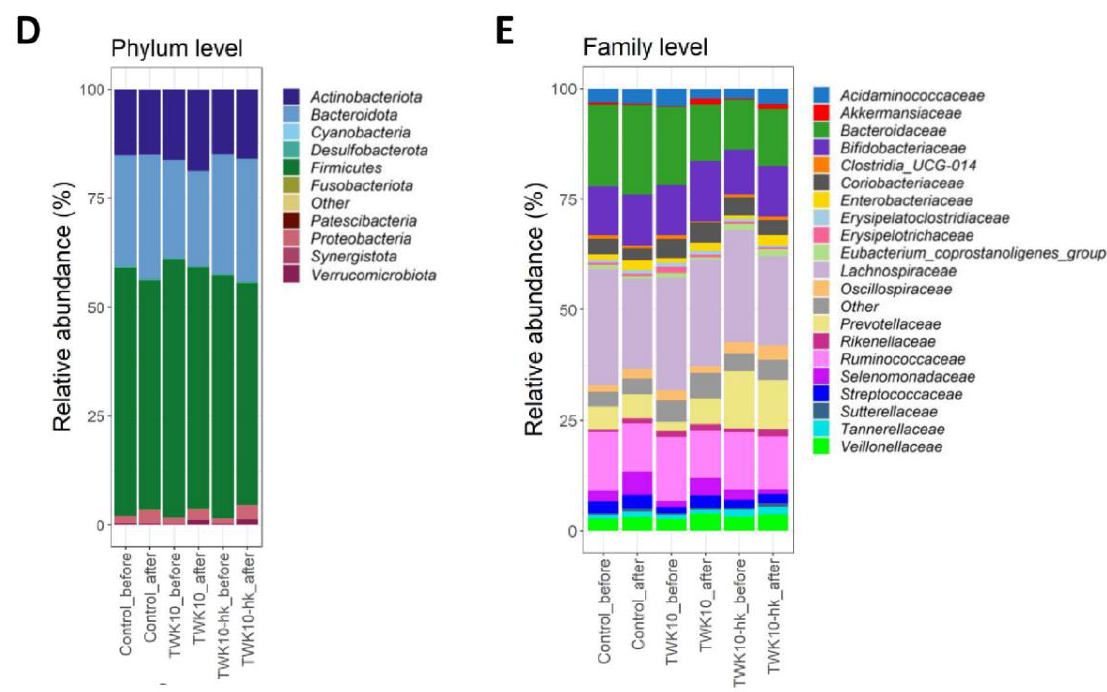
Figure 3. Comparisons of bacterial diversity among groups and its changes in response to interven- tion: ( A ) Box plots showing differences among the three groups (Control, TWK10, and TWK10-hk) in α -diversity indices (Shannon index and observed ASVs) before and after administration. Each box plot illustrates the median, interquartile range, minimum, and maximum values. ASV: Amplicon Sequence Variants; ( B ) NMDS plots of bacterial β -diversity based on weighted UniFrac distance (left panel) and unweighted UniFrac distance (right panel); ( C ) Distances of bacterial β -diversity based on the weighted UniFrac distance (left panel) and unweighted UniFrac distance (right panel). Comparisons of bacterial composition based on the top 10 phyla ( D ) and top 20 families ( E ) of bacteria in all samples. Others, remaining phyla or families with lower relative